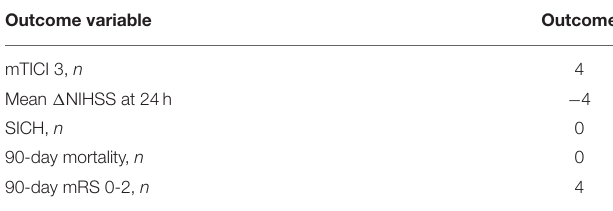
TABLE 3 | Outcome Data for EVT > 24h. Outcome